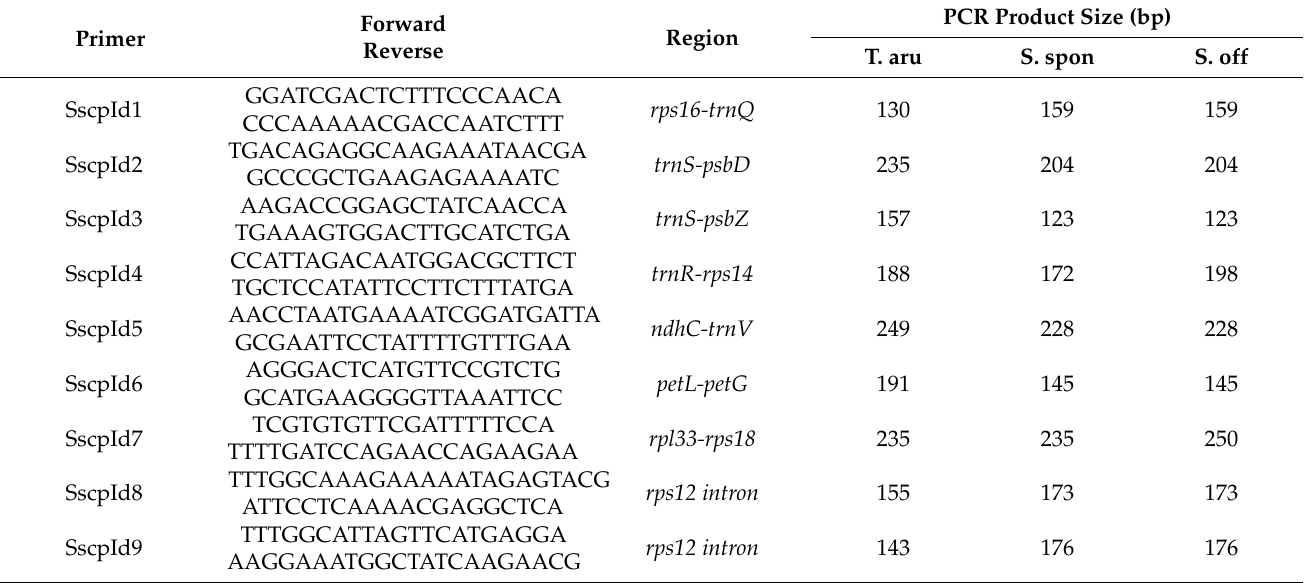
Table 2. Information of nine InDel markers designed for T. arundinaceum, S. spontaneum , and S. officinarum .